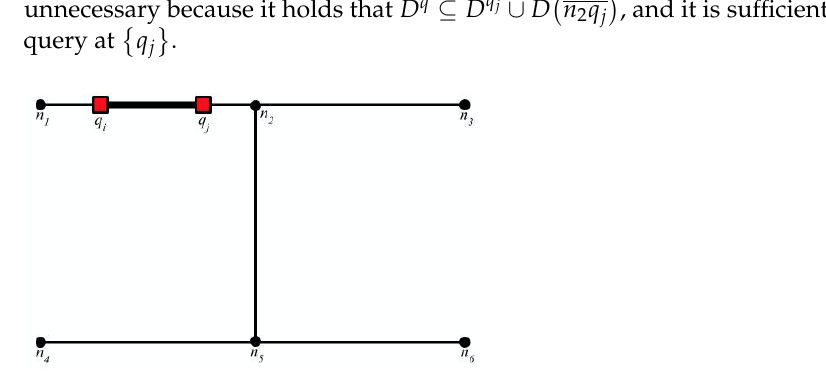
Figure 5. Heuristic D q ⊆ D q j ∪ D